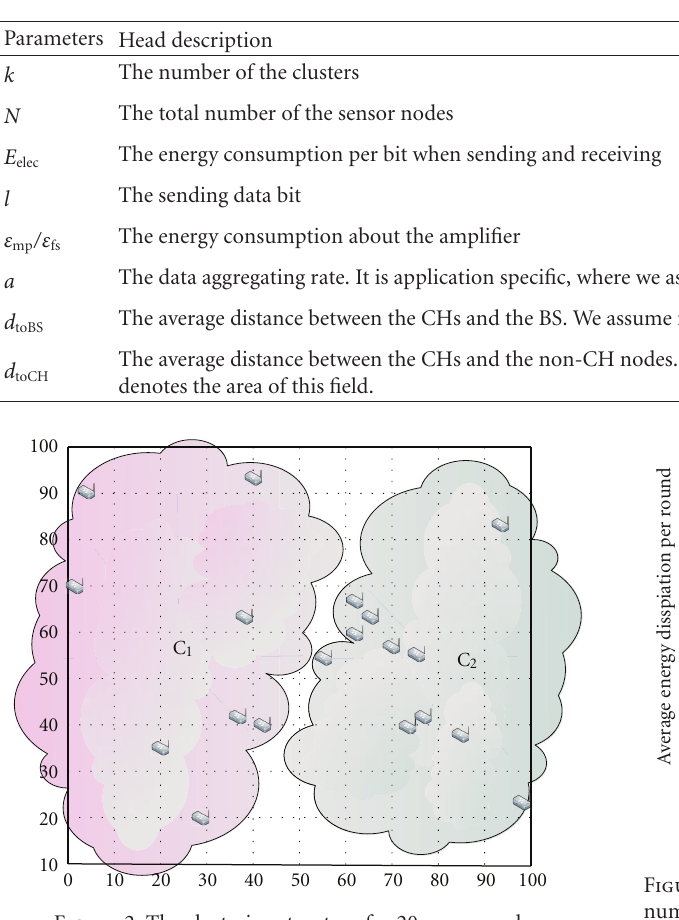
Table 1: Parameter description.